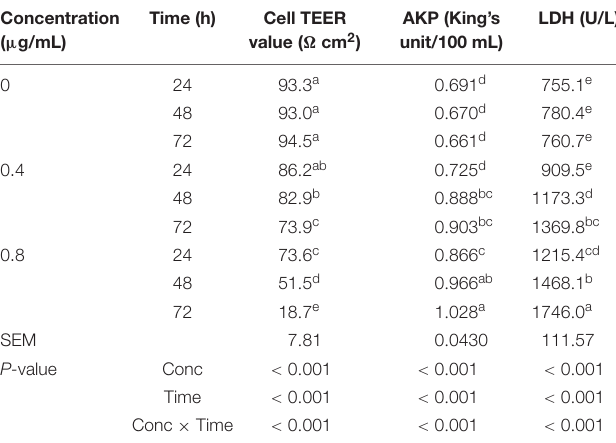
TABLE 6 | Effects of α -chaconine on the distribution and relative expression of tight junction proteins in mouse intestinal epithelial cells.